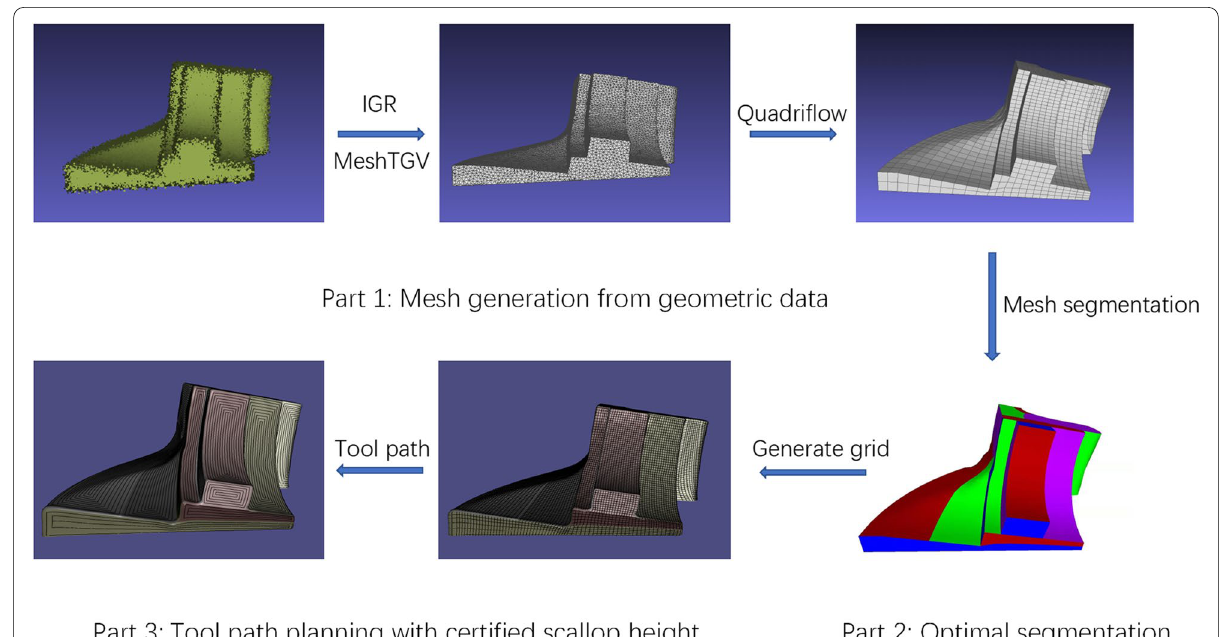
Fig. 1 Pipeline of the total